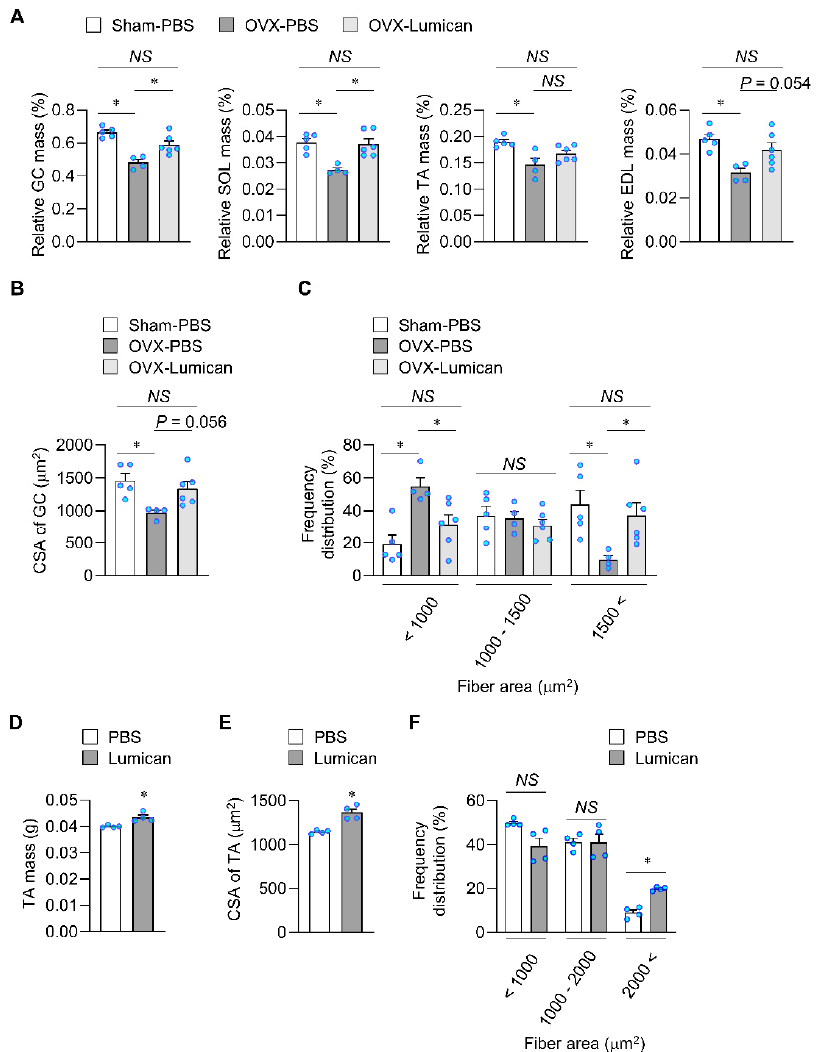
(H&E) staining to examine the CSA of GC muscles (Supplementary Figure S5A). The CSA of (Supplementary Figure S5A). The CSA of muscle fibers was reduced in OVX mice when muscle fibers was reduced in OVX mice when compared with that of sham-operated mice, compared with that of sham-operated mice, and lumican treatment marginally increased and lumican treatment marginally increased the CSA in OVX mice ( p = 0.056) (Figure 7B). the CSA in OVX mice ( p = 0.056) (Figure 7B). Notably, lumican treatment decreased the Notably, lumican treatment decreased the number of small fibers but increased that of large number of small fibers but increased that of large fibers in OVX mice (Figure 7C). fibers in OVX mice (Figure 7C).